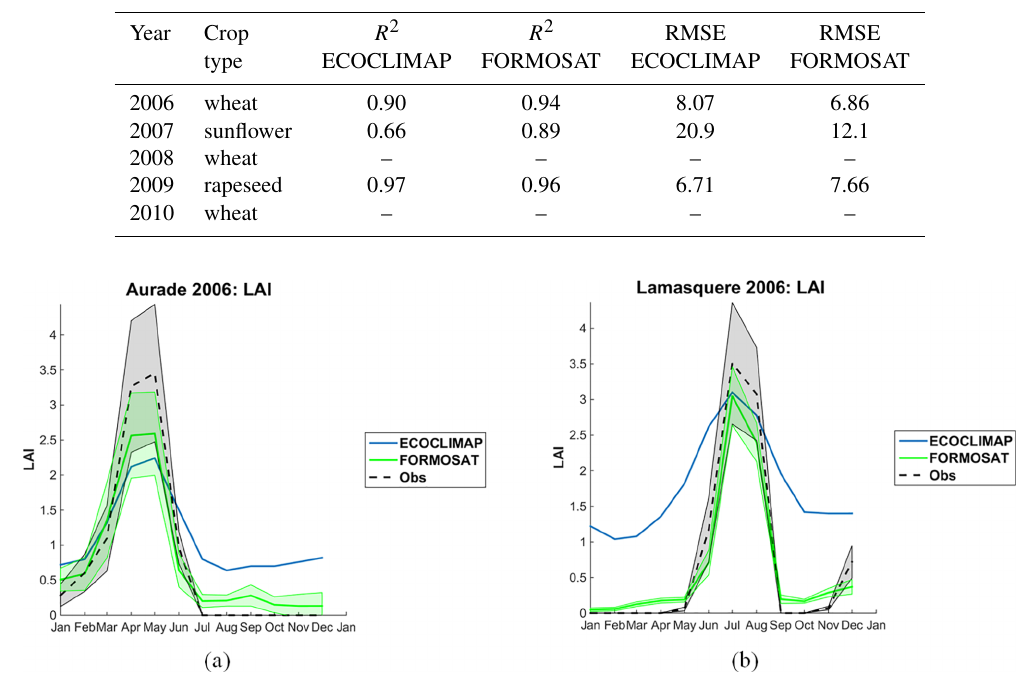
Figure 3. LAI time series for Auradé (a) and Lamasquère (b) for 2006. The filled areas represent the standard deviations for the measured (gray) and remotely sensed (green) time series.